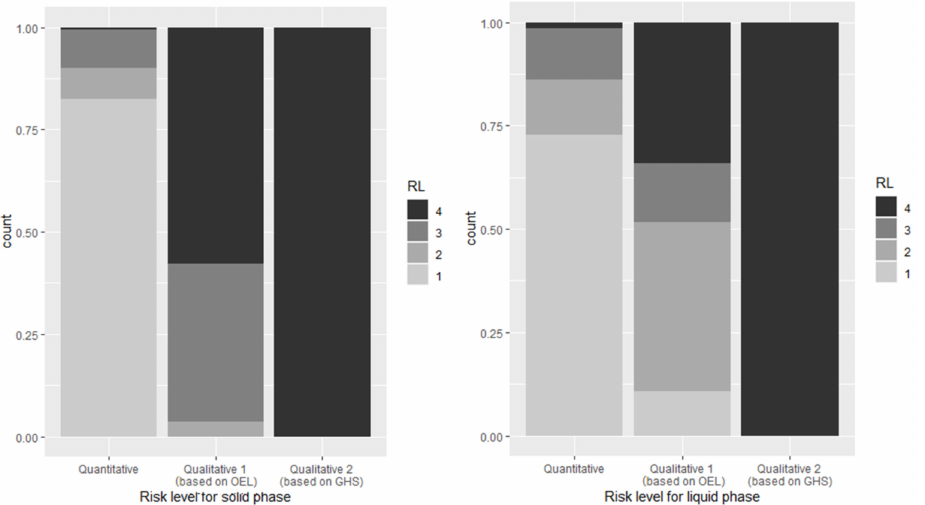
Figure 3. Risk level (RL) for each phase and branch based on available information. The H band derived from OEL was categorized as band 1 at 176 (15.7%), band 2 at 122 (10.4%), band 3 at 819 (70.4%), and band 5 at 47 (4.0%) locations among 1164 locations for all materials, band 2 at 63 (8.9%) and band 3 at 645 (91.1%) locations among 708 locations for handling solid materials, and band 1 at 176 (38.6%), band 2 at 59 (12.9%), band 3 at 174 (38.2%), and band 5 at 47 (10.3%) locations among 456 locations for handling liquid materials. The H band derived from the hazard statements was band 5 at 1164